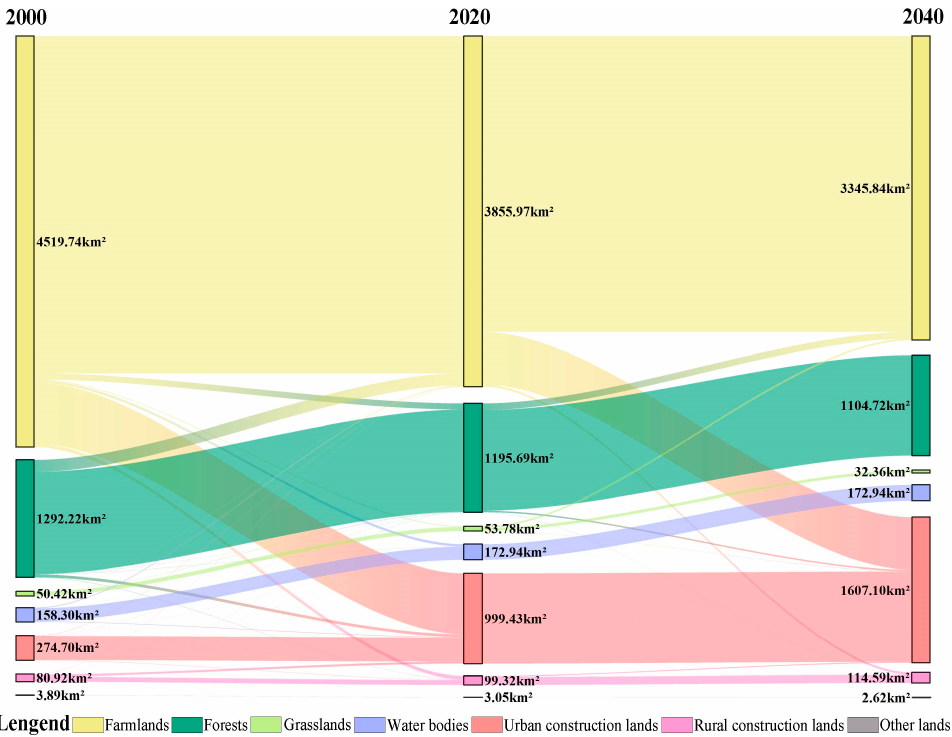
Figure 4. Sankey diagram for comparison of land-use dynamics in two-time intervals defined by three land-use maps for the years 2000, 2020 and 2040. Table 4. Transfer matrix of land-use from 2000 to 2020.